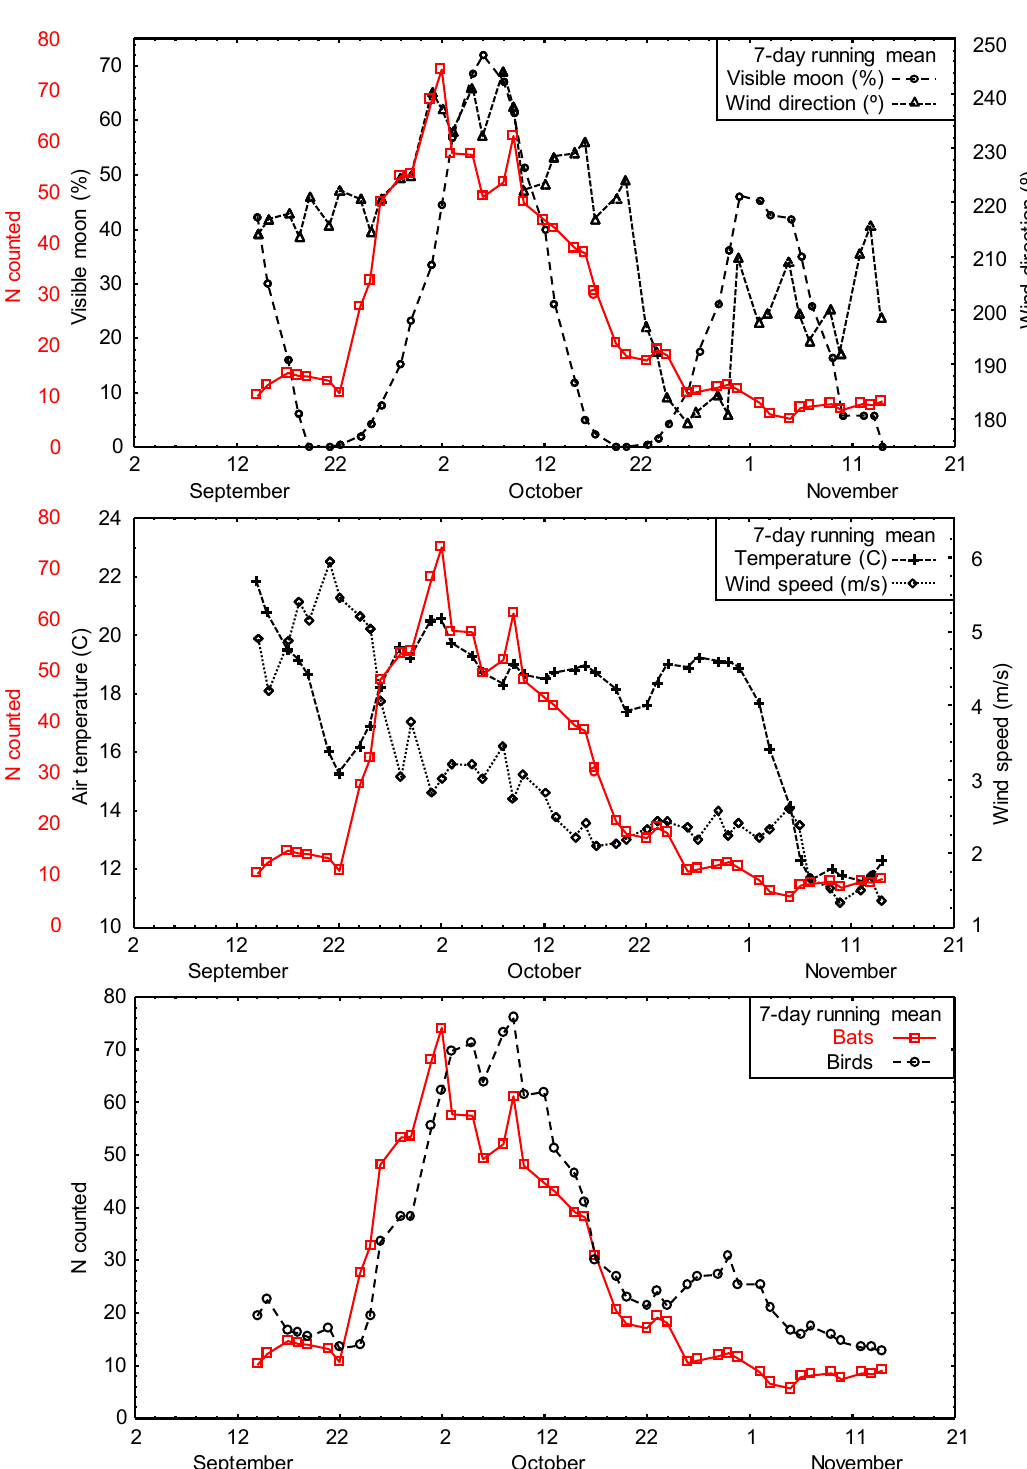
Figure 6. Running means (7 days) of visible moon and wind direction (top graph), air temperature (C) and wind speed (m / s) at ground level (middle graph), and nightly counts of all bats and birds observed flying (bottom graph) during surveys in the Altamont Pass Wind Resource Area, California, 4 September through 14 November 2017.